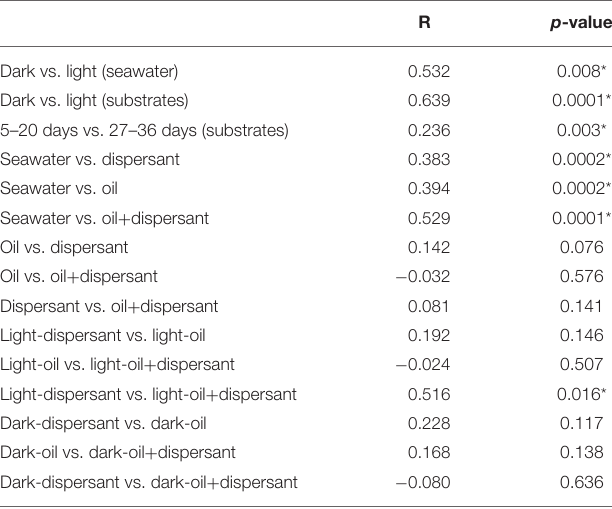
TABLE 2 | Pairwise comparison of bacterial communities in dark and light incubations based on ANOSIM with the Bray-Curtis distance ( P -values). R p